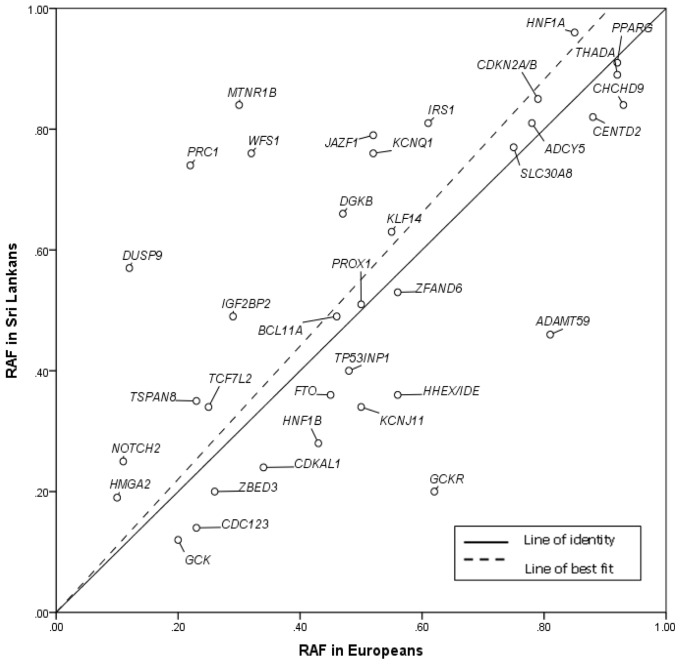
Comparison of risk allele frequencies (RAF) between South Asians from Sri Lanka samples included in this study (cases and controls combined) and previously reported RAF for Europeans (from HapMap).